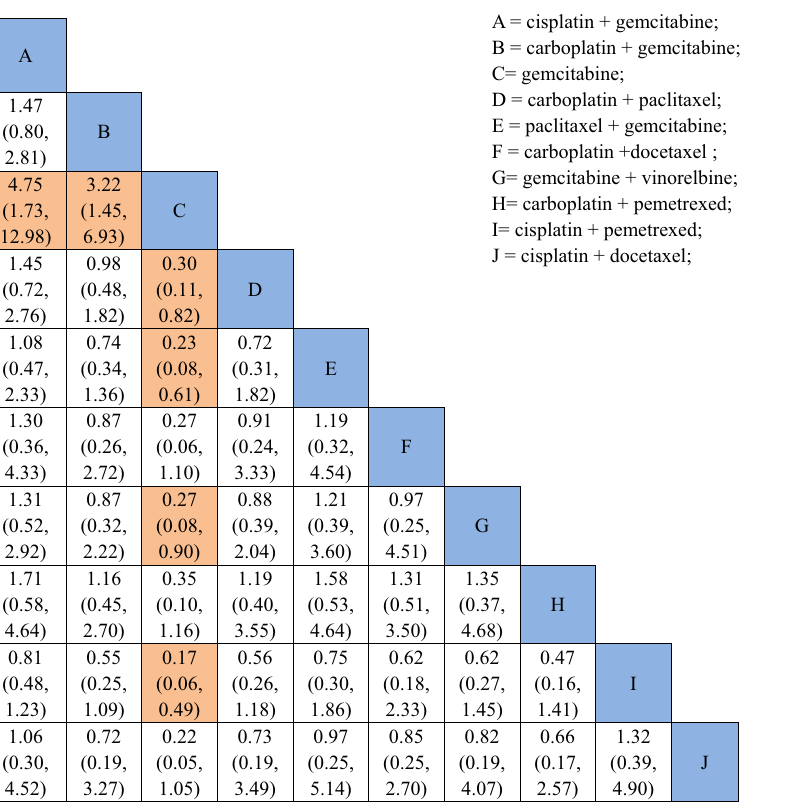
Figure 5: Network meta - analysis results in comparing the 10 fi rst - line chemotherapy regimens. A = cisplatin + gemcitabine, B = carboplatin + gemcitabine, C = gemcitabine, D = carboplatin + paclitaxel, E = paclitaxel + gemcitabine, F = carboplatin + docetaxel, G = gemcitabine + vinorelbine, H = carboplatin + pemetrexed, I = cisplatin + pemetrexed and J = cisplatin +